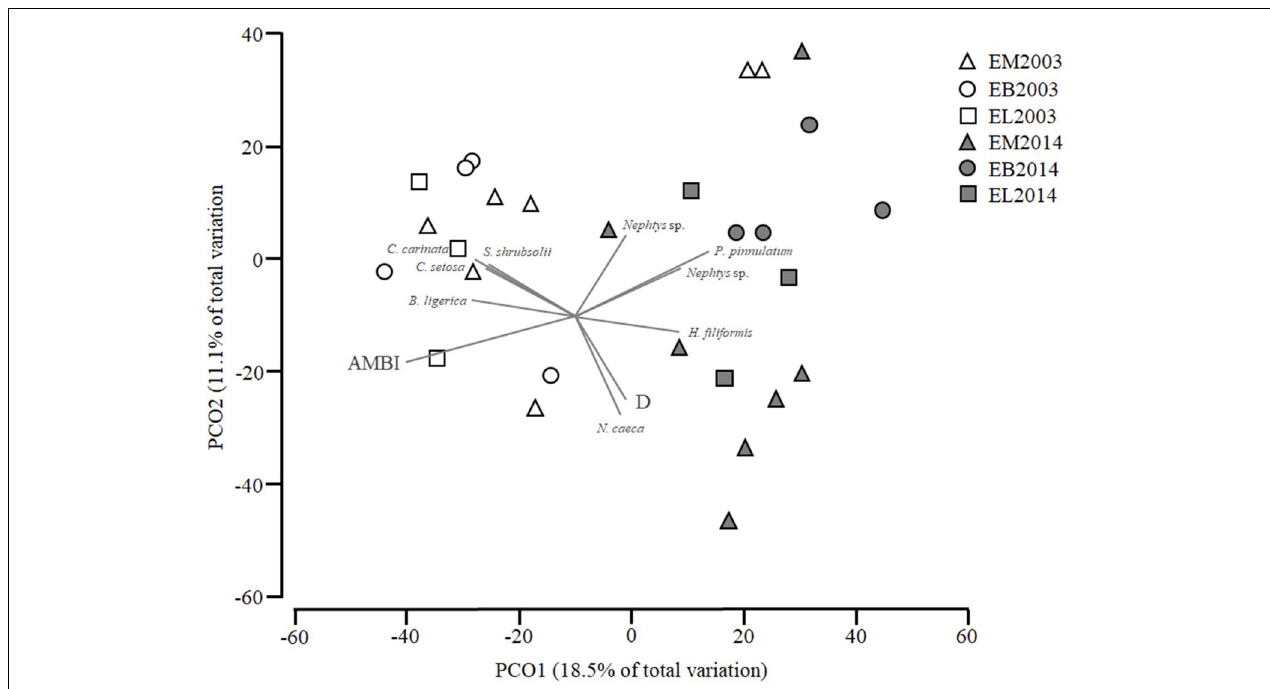
FIGURE 6 | Principal coordinates analysis (PCoA) of soft bottom macrobenthic communities within estuary (EM; EB;EL) Correlation with AZTI’s Marine Biotic Index (AMBI) and Distribution (D) are shown as well as species which have a Pearson correlation of at least 0.4 with PCO1 or PCO2.